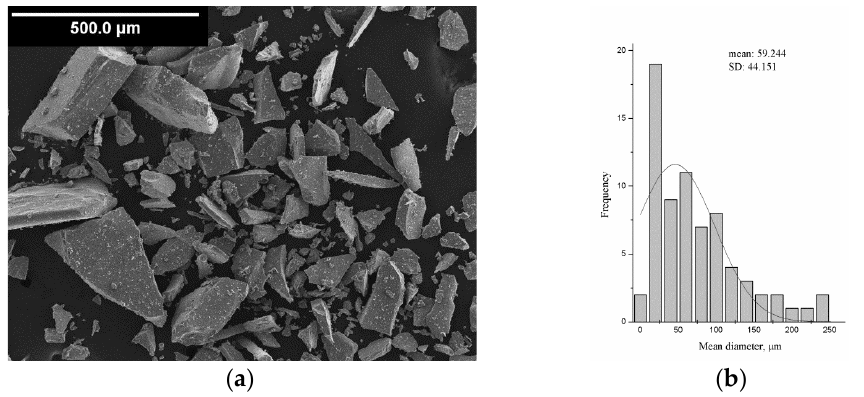
Figure 1. ( a ) SEM image, and ( b ) particle size histogram of used Nd-Fe-B alloy. A combination resin-hardener thermosetting epoxy binder has been used as the PBM matrix. The resin was obtained by mixing two types of bisphenol, A-type and F-type, and subsequently modified using a suitable dysfunctional reactive solvent, as reported elsewhere [39]. The hardener is a modified cycloaliphatic polyamine. The mixture’s pot life is 40 min at 20 ◦ C. After 24 h, 80–90% solidification can be achieved. The minimum and maximum solidification temperatures are 10 ◦ C and 40 ◦ C, respectively, while the optimal solidification temperature ranges from 20–25 ◦